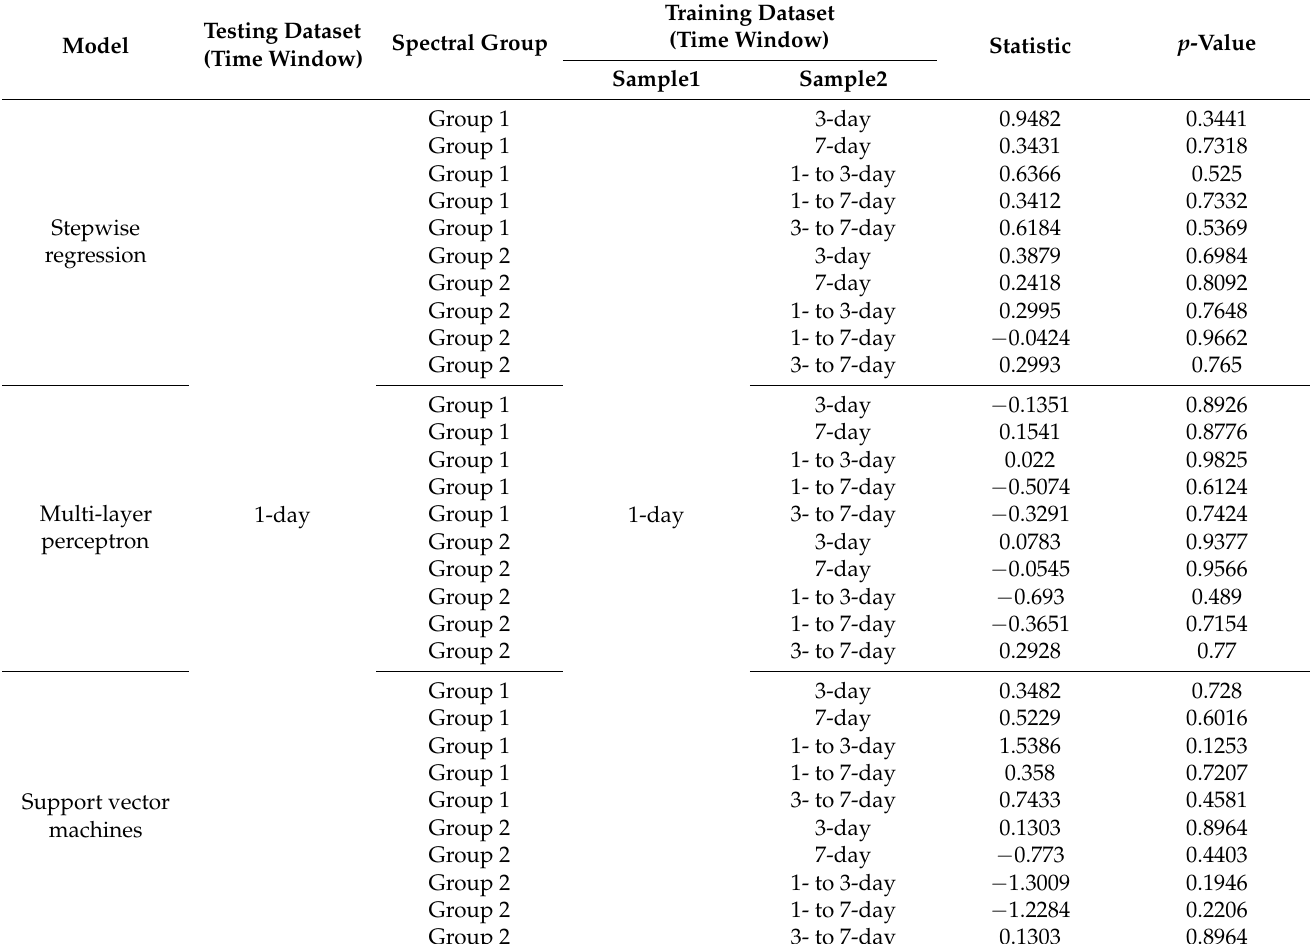
Table 7. Difference in prediction results between models trained with a 1-day time window dataset and models trained with other time window training datasets (using 1-day time window data as a testing dataset). Group 1 represents the spectral variables that used a single band or band combination. Group 2 represents the spectral variables that used a band combination and band ratio